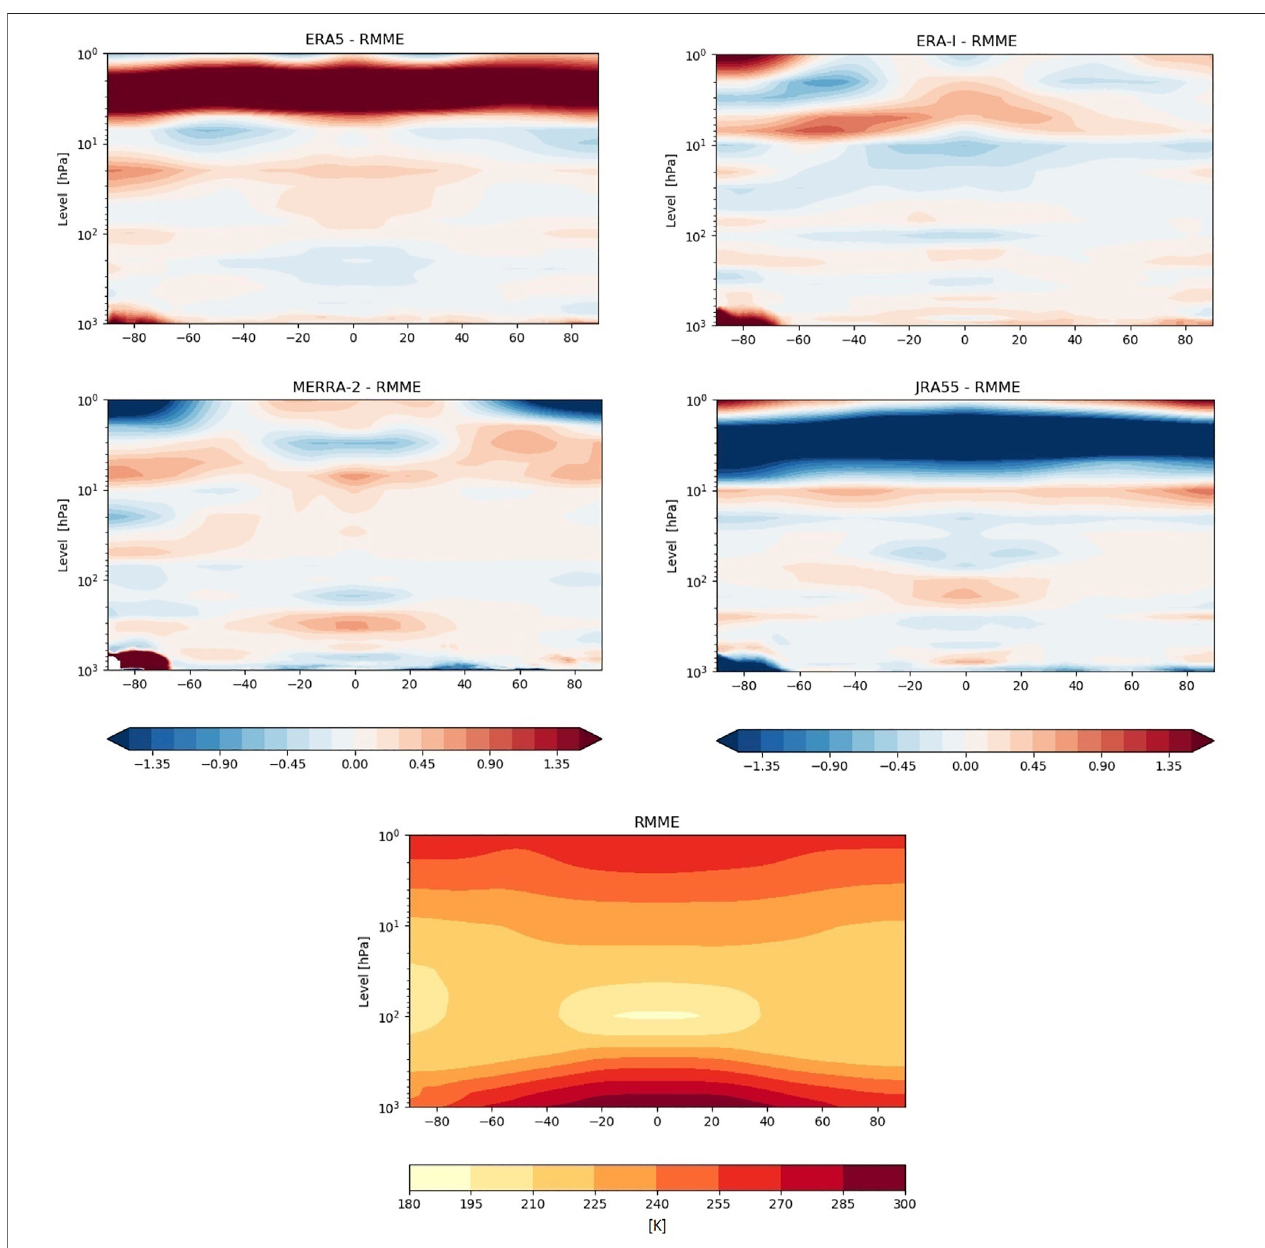
FIGURE 1 | Zonal mean of annual mean temperature difference between reanalyses and RMME for the period (1980 – 2018), and RMME zonal mean temperature map (bottom panel).